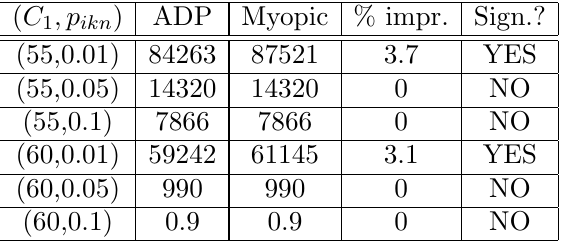
Table 8. Results for the relaxed tol- erance high late scheduling case with N =